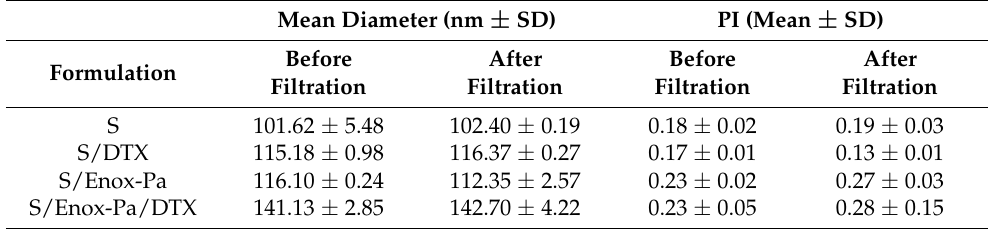
Table 4. Size and PI of formulations with and without Docetaxel in NaCl (0.9% w/v ) at time 0 and after filtration through a cellulose acetate filter (pore size: 0.2 µ m). Indicated values are mean ± SD (n =